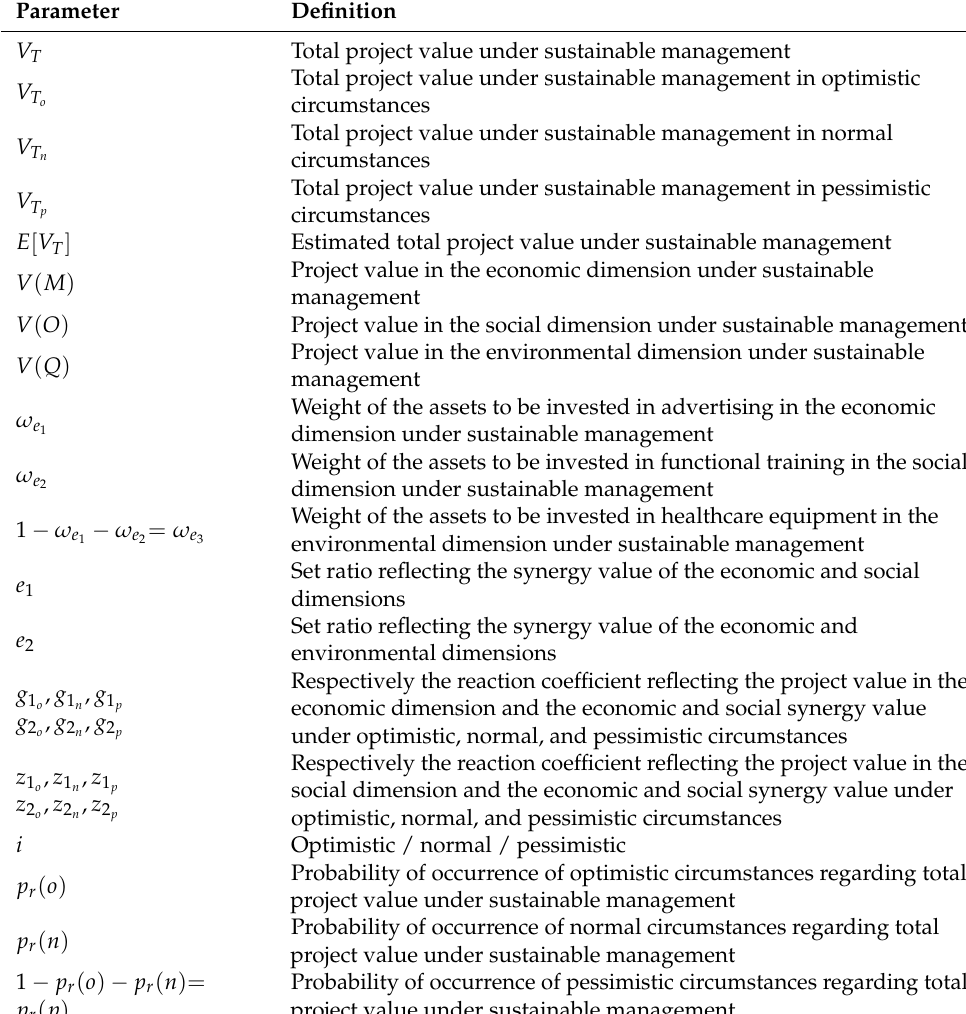
Table 3. Definitions of